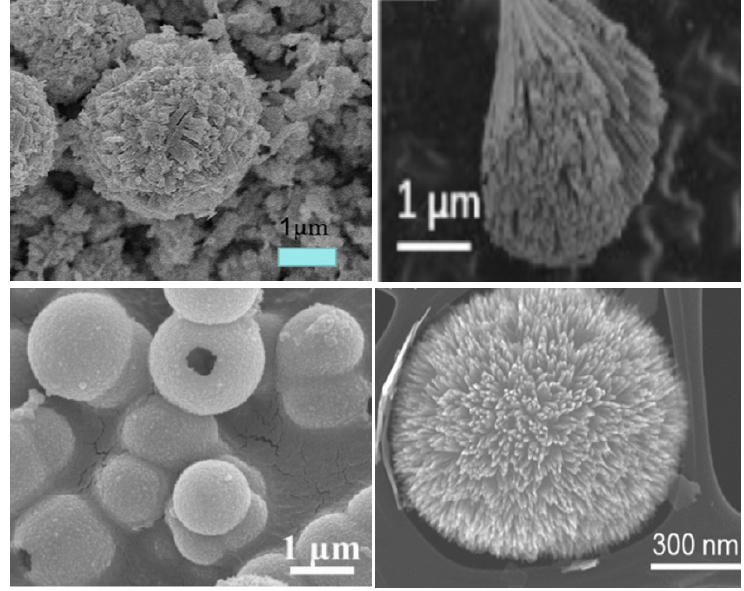
Figure 13. SEM micrographs of some hierarchical photocatalysts obtained without templates [149,151,158,160].